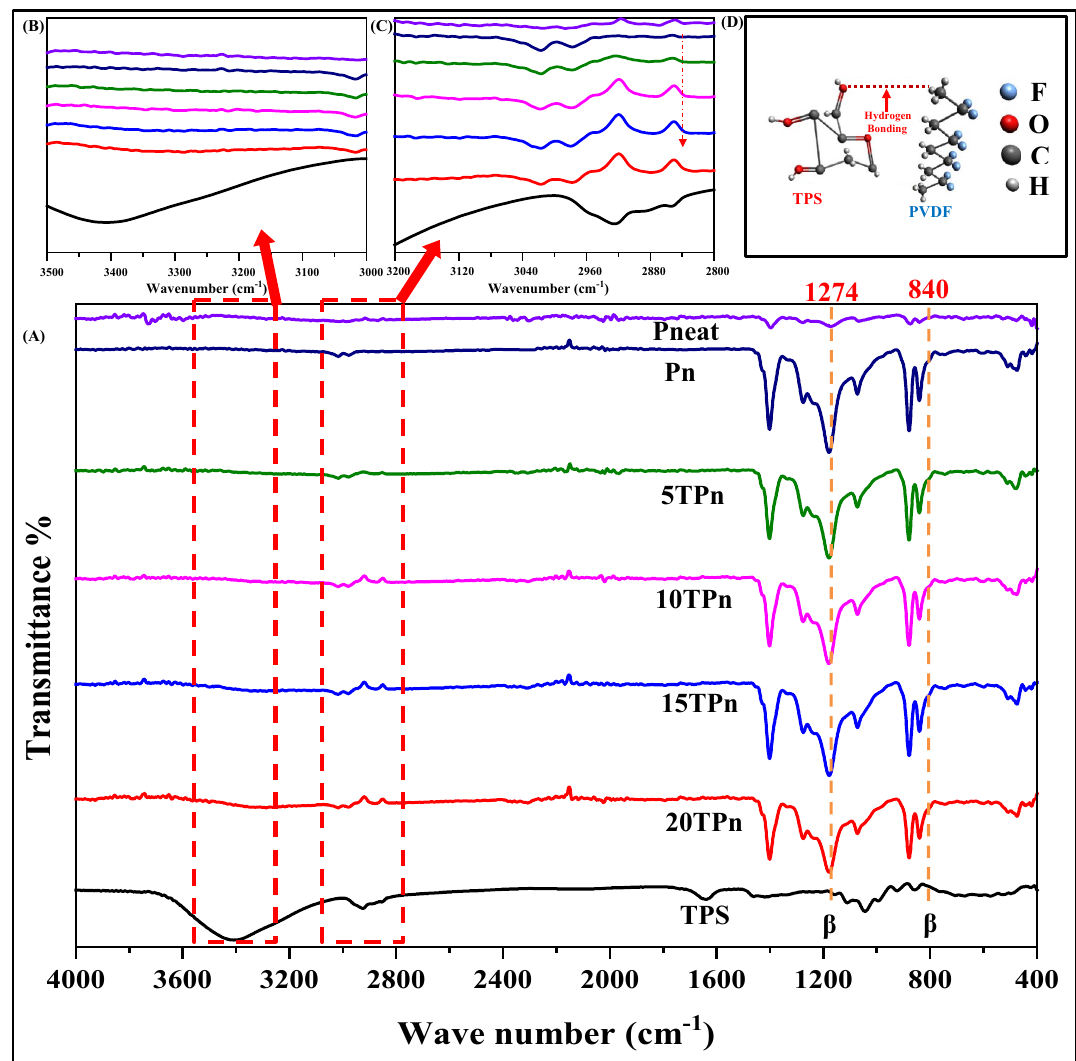
Figure 3. ( A ) FTIR spectra including ( B , C ) new characteristic bands of TPS/PVDF nanofibers and ( D ) Molecular interaction between TPS and PVDF.